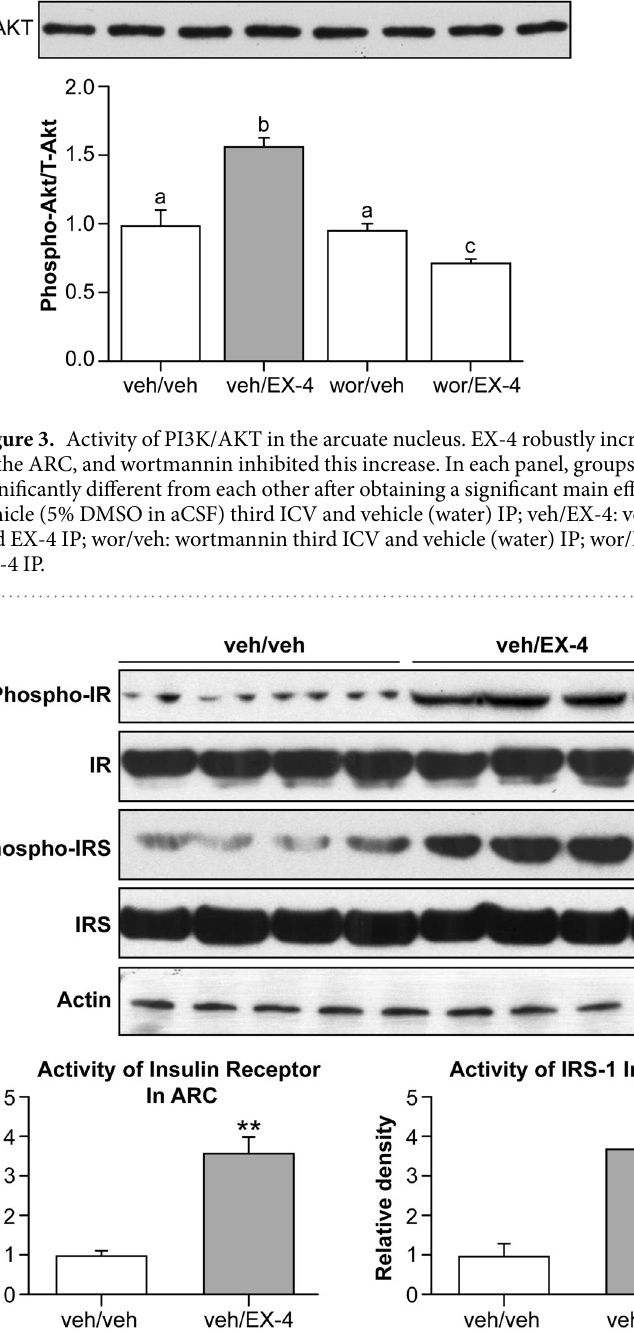
treatment with EX-4 increased POMC and decreased NPY expression in the hypothalamus of rats 8 . Meanwhile, there is evidence showing that GLP-1 receptors exist in the POMC/CART neurons, but not in NPY/AgRP neu- rons 33 . Previous studies have shown that EX-4 increases the activity of PI3K in peripheral tissues, such as liver,